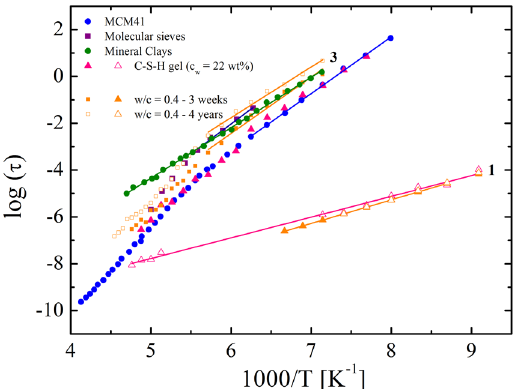
Figure 6. Comparison of the temperature dependence of relaxation times of water confined in Portland cements with different w/c ratio, in C-S- H gel 20 , molecular sieves (1 nm) 51 , MCM-41 (1 nm) 26 and mineral clays 52